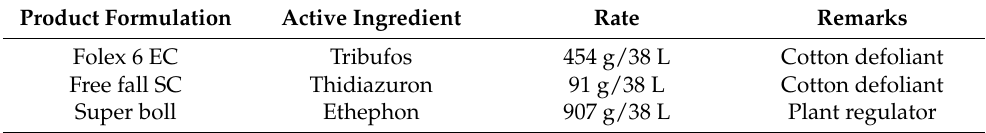
Table 2. Chemical formulations, active ingredients, and application rates used for this